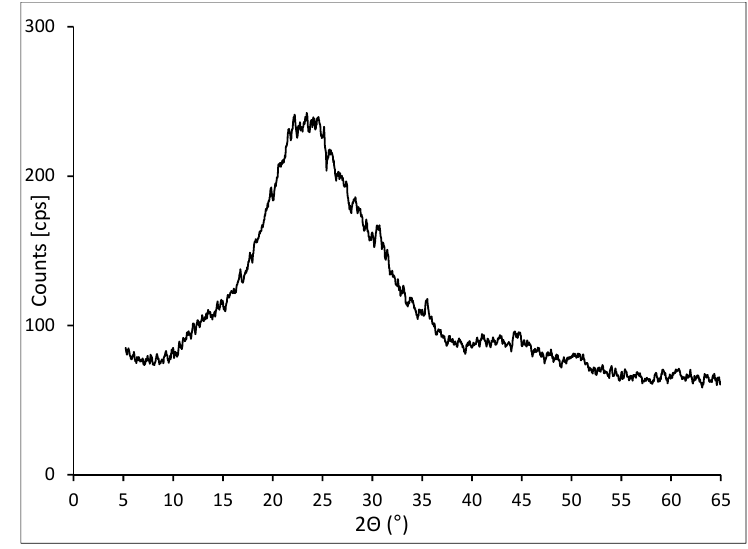
Figure 1. X-ray di ff raction pattern of LCD Figure 1. X-ray diffraction pattern of LCD material.